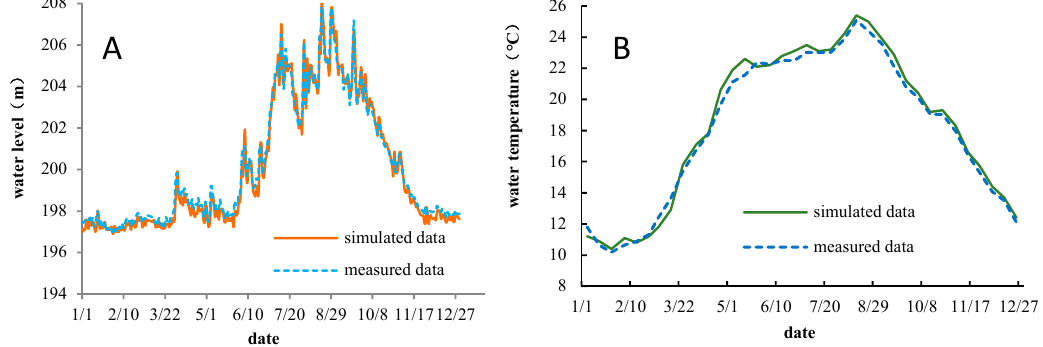
Figure 2. HEC-RAS model verification. ( A ) The water level at Zhutuo in 2014. ( B ) The water temperature at Cuntan in 2014.